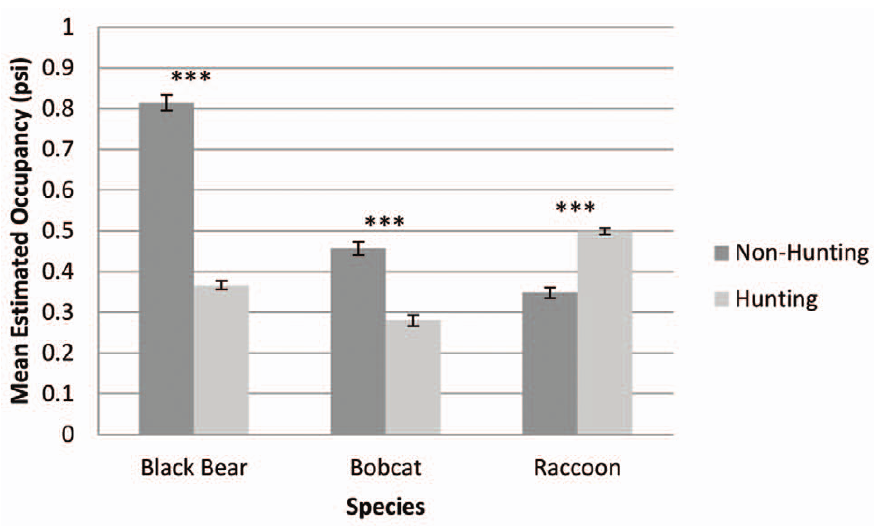
Figure 2. Mean and standard error of estimated occupancy in hunting vs. non-hunting areas for the 3 species for which hunting was present in the top models and received . 0.5 Akaike weight. Asterisks represent level of significance based on two sample t-test assuming unequal variance (***=p , 0.001).